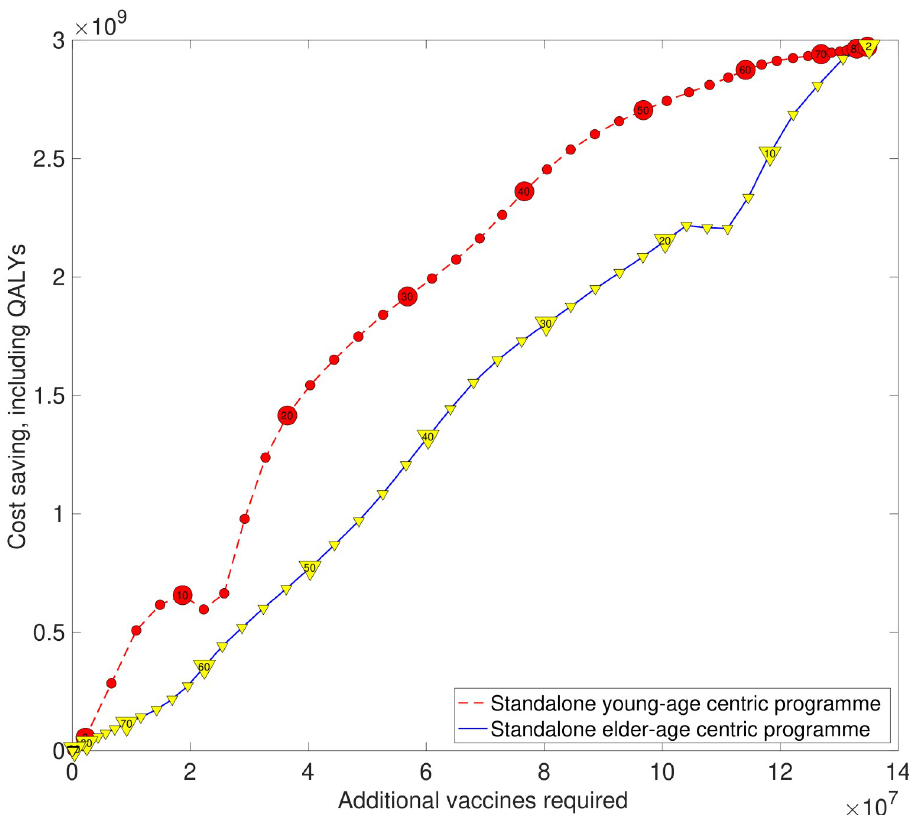
Fig 6. Estimated savings against additional administered vaccines for alternative vaccine programmes (relative to an at-risk only vaccination programme). The plotted points represent estimates for a single vaccine programme, with one QALY valued at £30,000 and the vaccine cost set at the threshold value that 90% of simulation replicates remain cost-effective. The red dashed line with circle markers corresponds to young-age centric strategies. Numerical values contained within the circle markers state the upper bound of age coverage represented by that particular young-age centric strategy (e.g. the marker containing “20” represents a strategy covering those between 2 to 20 years of age). The blue solid line with inverted yellow triangle markers corresponds to elder-age centric strategies. Numerical values contained within the inverted triangle markers express the lower bound of age coverage represented by that particular elder-age centric strategy (e.g. the marker containing “20” represents a strategy covering those aged 20 years old and above). Standalone young-age centric strategies perform well, forming a rough upper bound on potential savings. In contrast, standalone elder-age centric strategies typically display less effective